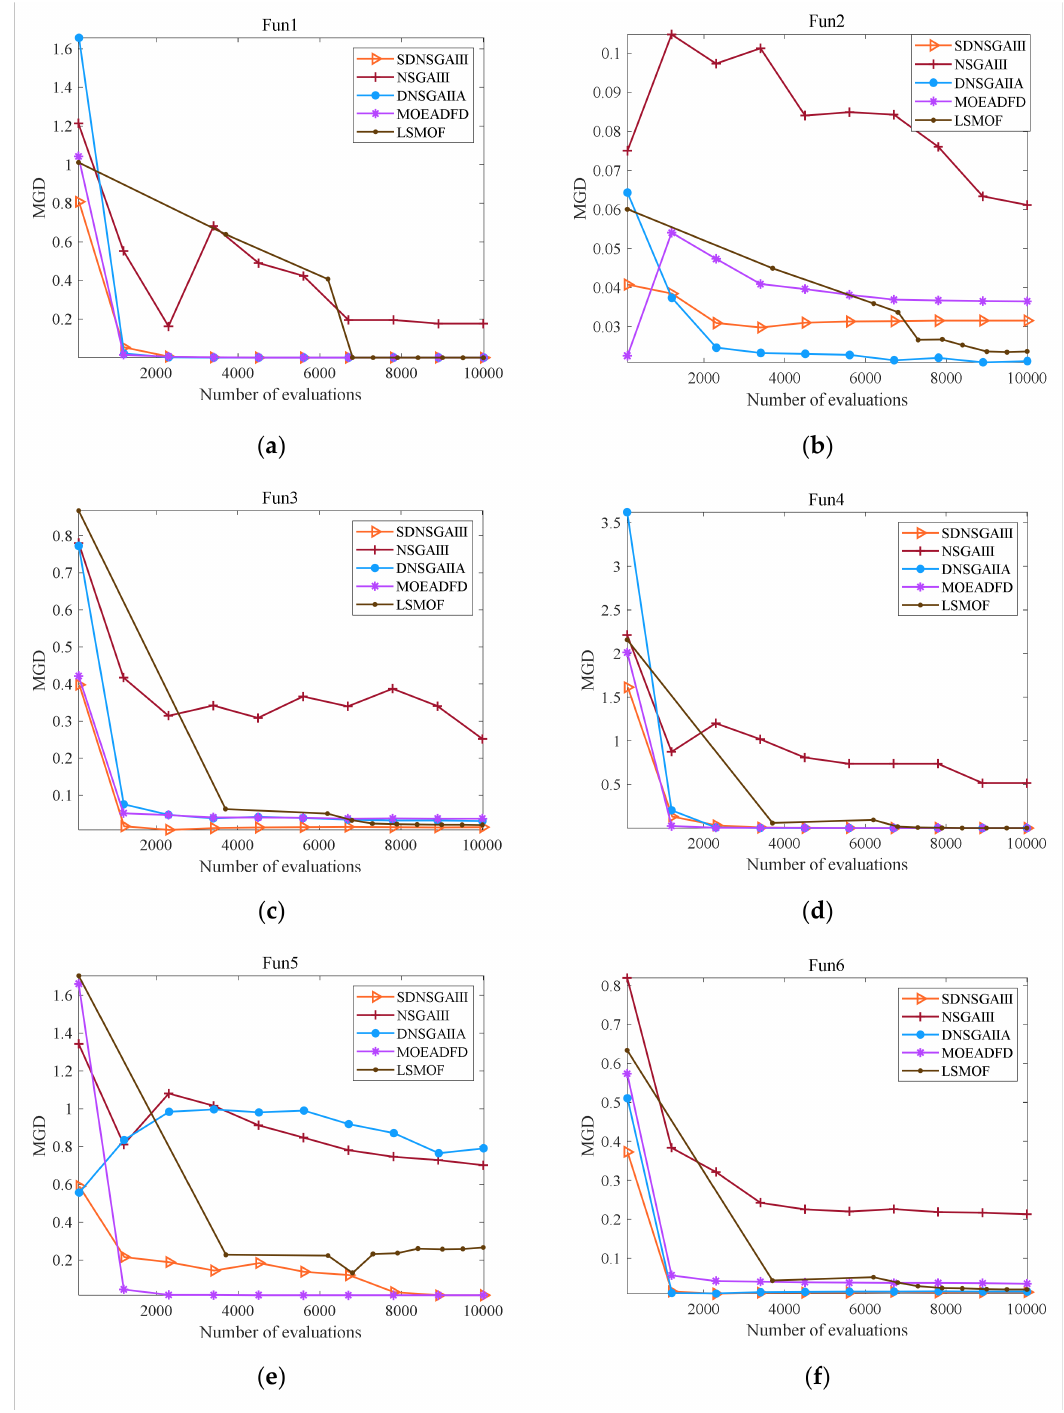
Figure 4. The MGD trend of five algorithms with n t = 10, τ T = 20. ( a – f ) are MGD trend graphs of six functions respectively. The statistical results of six benchmarks and six parameters on MIGD , MHV , and MGD are recorded in Tables 4 and 5 respectively. Among the six different benchmarks, SDNSGA-III reached 18 best results on Fun1, which has dynamic DPS and static DPF . In terms of the six different parameters, our proposed SDNSGA-III achieved the best metric values on the severe change severity ( n t = 5) and the slow change frequency ( τ T = 20). The performance of SDNSGA-III was nearly the same on the rest of the five parameters. Generally, SDNSGA-III is more suitable for DMOPs, since it has a relatively smooth